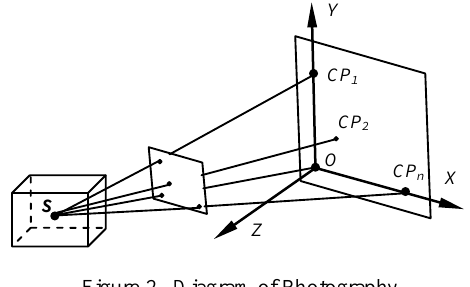
Figure 2. Diagram of Photography The flow chart of calculating the approximate values of exterior orientation elements of a image using PSO is shown as Figure 3.